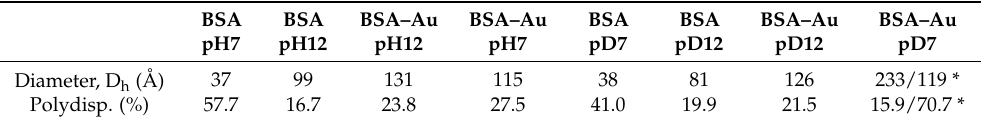
Table 4. Hydrodynamic radius of the BSA–Au and BSA systems in H 2 O and D 2 O at given pH (pD) values. The polydispersity index is also given in